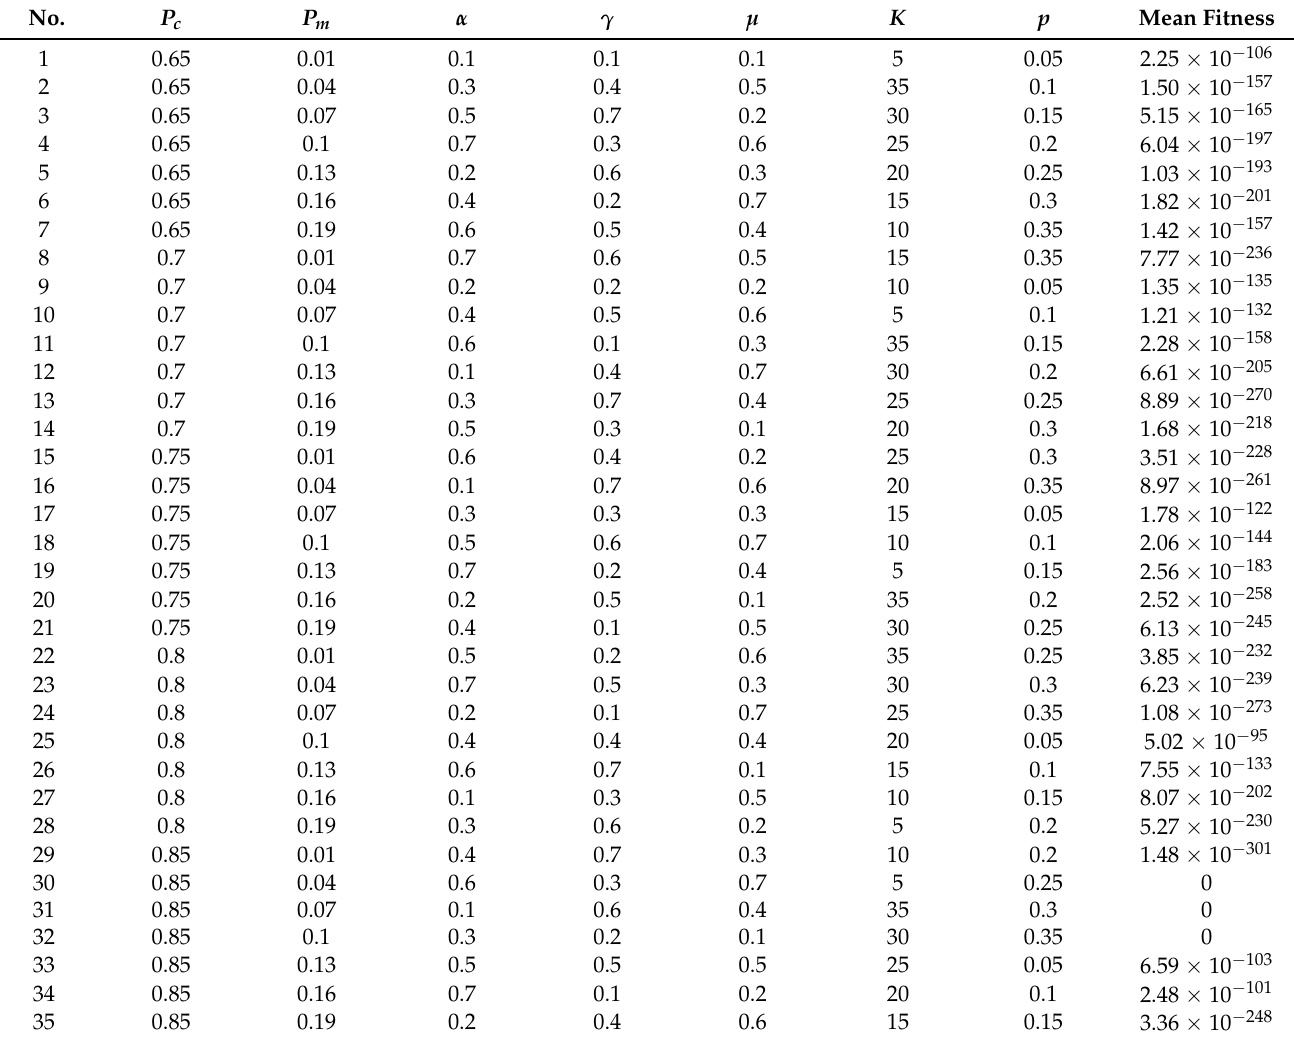
Table 3. Orthogonal parameter table of L 49 ( 7 ) 7 and experimental results on f 1 (Dimension =